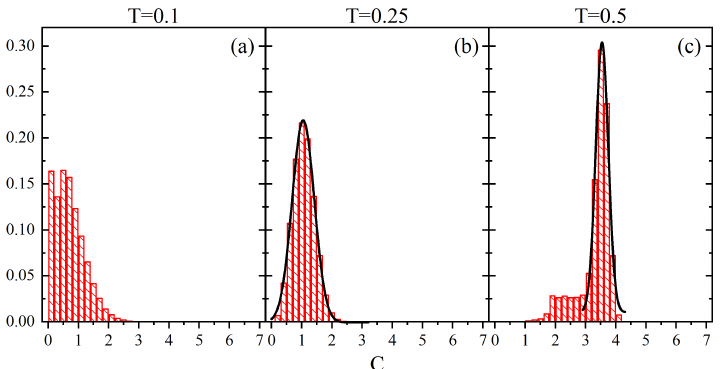
Figure 9. Normalized probability density ρ ( C ( (cid:126) r )) for T = 0.1 ( a ), T = 0.25 ( b ) and T = 0.5 ( c ). Solid lines represent gaussian fits (see